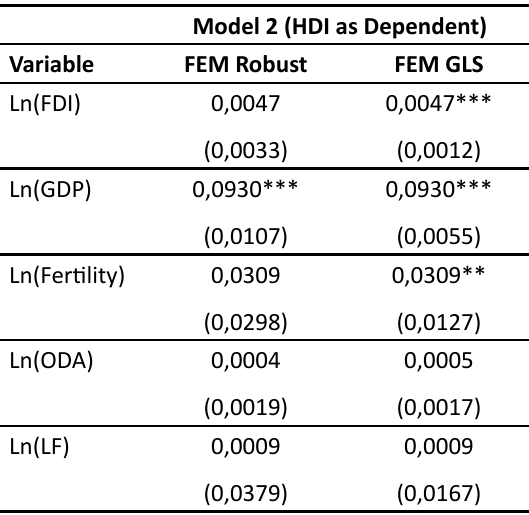
Tabel 5: FEM Robust and FEM